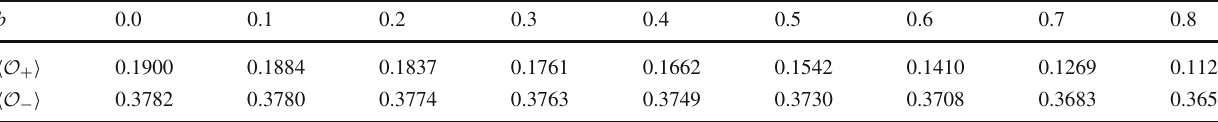
Table 1 The critical temperature T c for the operators (cid:2) O + (cid:3) and (cid:2) O − (cid:3) for different BI parameter